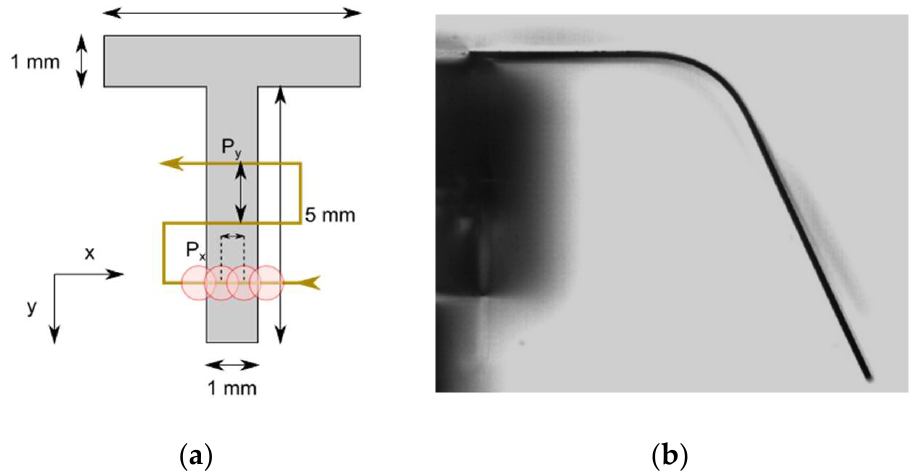
Figure 2. ( a ) The laser begins working at the furthest position of the cantilever section outside the sample. The stage moves as the axes are displayed; in this way, the working area is always in focus. The picture also shows P x and P y . ( b ) A 316 steel sample after the process.